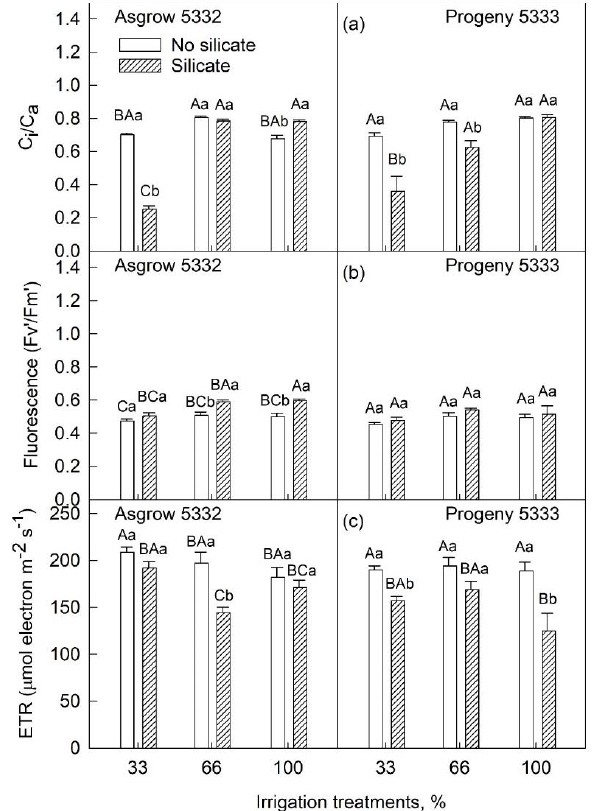
Figure 6. The influence of silicate application on two soybean cultivars: ( a ) the ratio of internal to external carbon dioxide concentration (C i /C a ), ( b ) fluorescence (Fv’/Fm’), and ( c ) electron transport rate (ETR) across three irrigation treatments, measured at 45 days after emergence of the seedling. The values are mean and standard errors of five replications in each treatment. The error bars correspond to standard error. The bars followed by the same letters (lower-case letters within silicate and no silicate and upper-case letters within irrigation and silicate treatments) did not differ significantly at 5% by Tukey’s test.